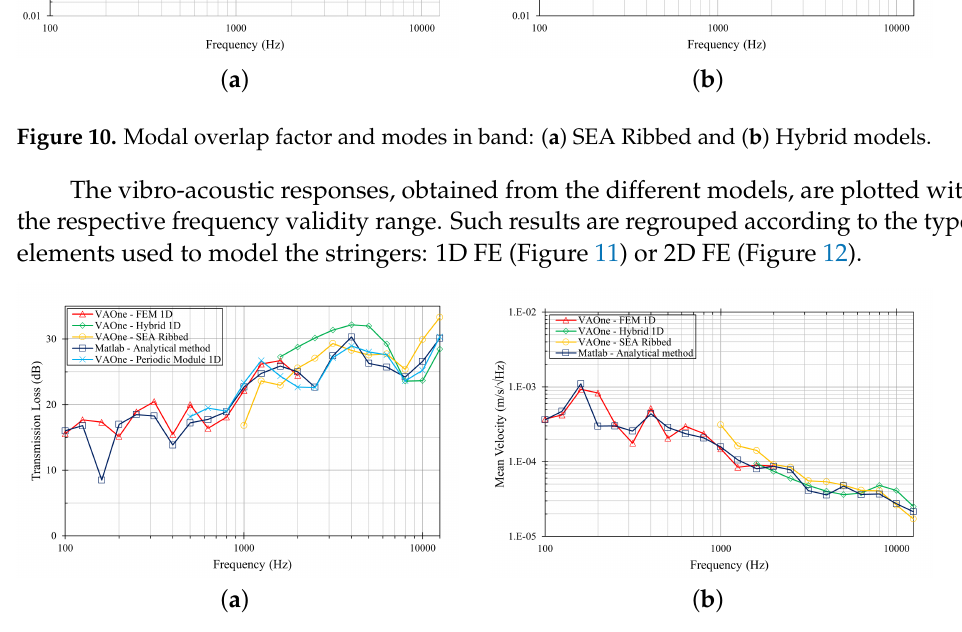
Figure 11. Vibro-acoustic responses of a panel with symmetrical Z stiffeners (1D stringers): ( a ) sound transmission loss and ( b ) space-average mean vibration velocity.